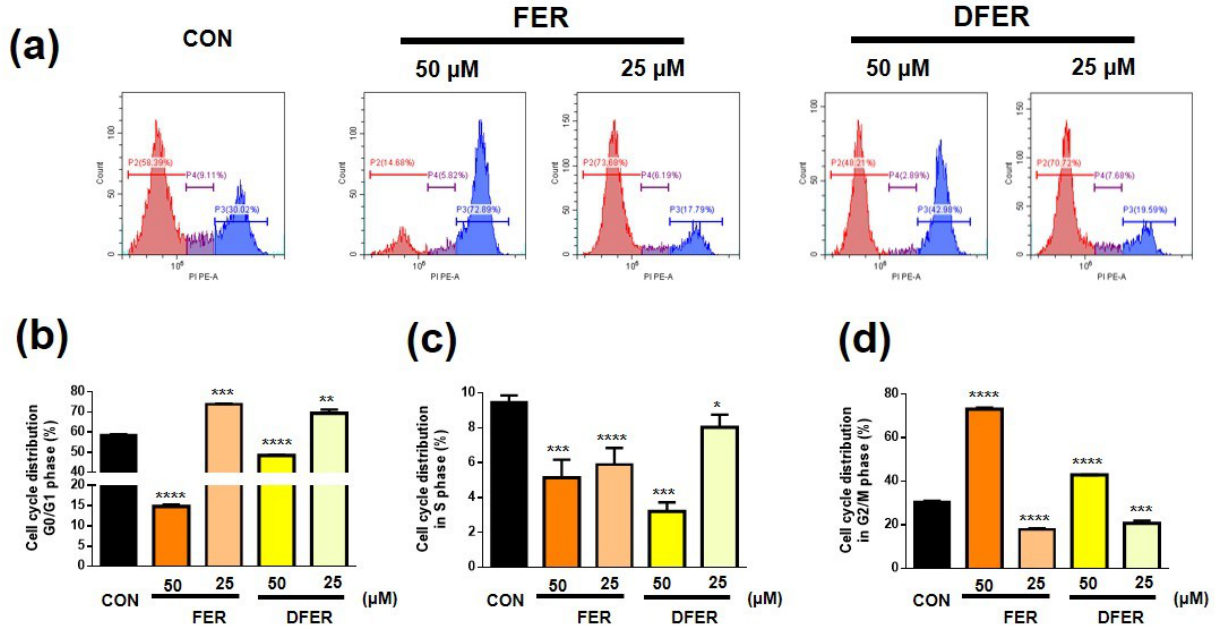
Figure 3. Treatment of FER and DFER arrest of HCT116 at the G2/M phase with a concentration of 50 µ M for 24 h. ( a ) Representative cell cycle distribution of FER- and DFER-treated HCT116 at either 25 or 50 µ M for 24 h. ( b – d ) Percentage of HCT116 distribution at G0/G1 phase, S phase and G2/M phase, respectively. Symbols (*), (**), (***) and (****) indicate significant differences ( p < 0.05), ( p < 0.01), ( p < 0.005) and ( p < 0.001), respectively, analyzed using Student’s t -test, as compared to the control group.